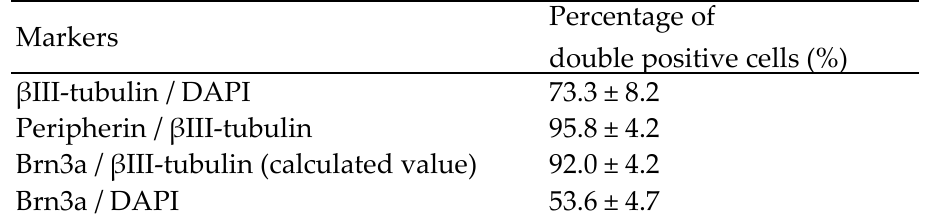
Figure 1. Immunocytochemical characterization for hiPSC-SNs. ( a ) After the culture of hiPSC-SNs for 6 days, neurons expressed βIII-tubulin (green) and peripherin (red). Nuclei were visualised with DAPI (blue). ( b ) The cells expressed peripherin (red) and Brn3a (green). ( c ) Percentages of the βIII-tubulin, peripherin, and DAPI-positive cells. Data are expressed as mean ± standard deviation. hiPSC-SNs: human-induced pluripotent stem cell-derived sensory neurons.